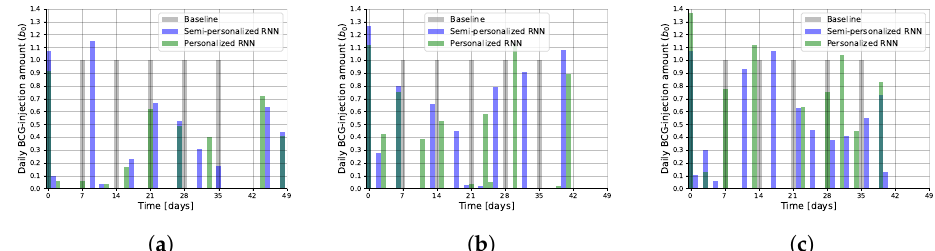
Figure 4. The treatment schedule derived for each of the examined cases. The x-axis represents time (in days), and the y-axis represents the administered BCG. Grey bars are associated with the baseline approach, blue with the semi-personalized RNN, and green with the personalized RNN. ( a ) Mild case ( T u ( 0 ) = 2 · 10 6 ). ( b ) Moderate case ( T u ( 0 ) = 7 · 10 6 ). ( c ) Severe case ( T u ( 0 ) = 2 · 10 7